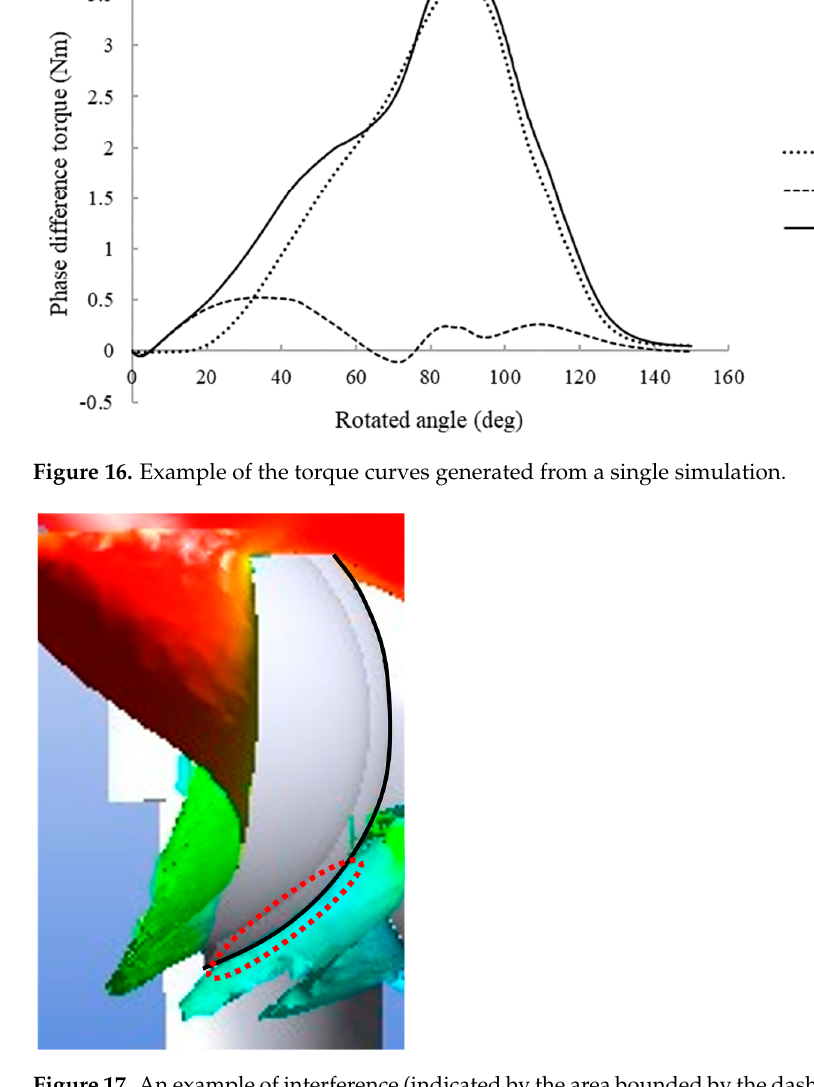
Figure 17. An example of interference (indicated by the area bounded by the dashed red line) between exiting flow and the back face of the trailing blade (indicated by the solid black line).